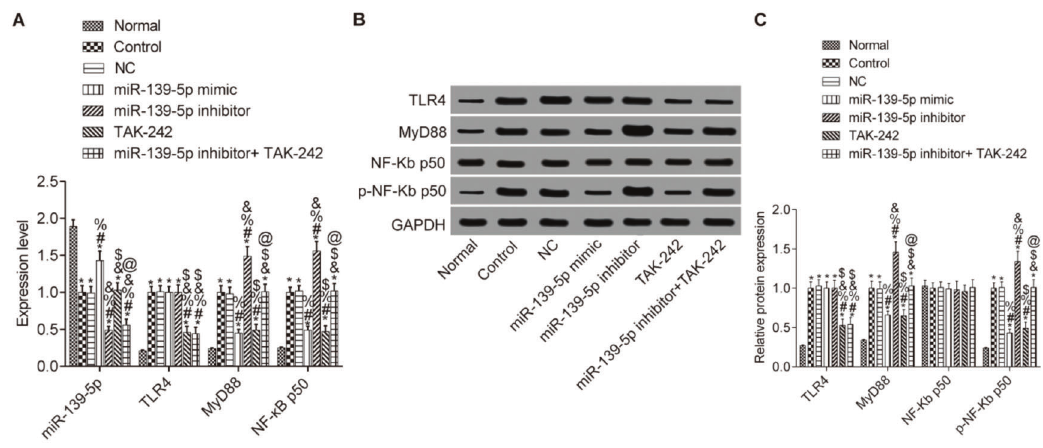
Figure 2 - Expression of miR-139-5p, TLR4, MyD88, and NF- k B p50 in the lung tissue of each group. The mRNA levels of miR-139-5p, TLR4, MyD88, and NF- k B p50 in mouse lung tissue (A); The protein expression levels of TLR4, MyD88, NF- k B p50 and p-NF- k B p50 in mouse lung tissue (B–C). Significant comparisons with each group, where p o 0.05, are indicated by: ‘‘ * ’’ for the Normal group, ‘‘ # ’’ for the Control group, ‘‘ % ’’ for NC group, ‘‘ & ’’ for the miR-139-5p mimic group, ‘‘ $ ’’ for the miR-139-5p inhibitor group, and ‘‘ @ ’’ for